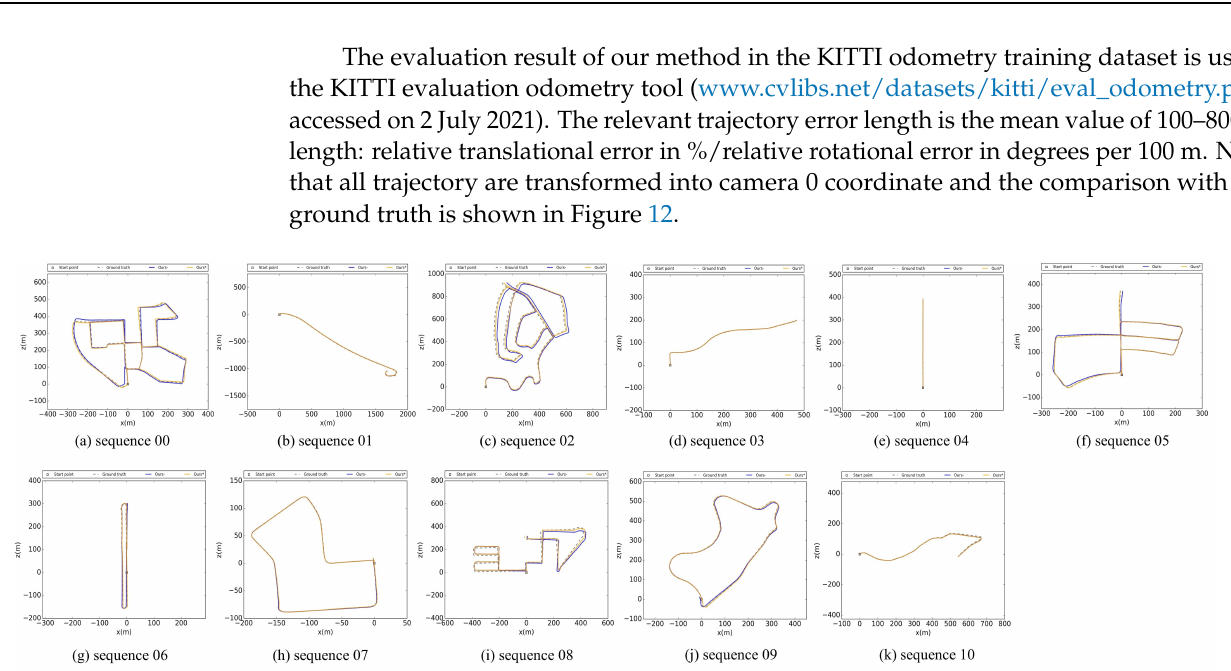
Figure 12. Trajectory diagram concerning the training set and the corresponding sequence error results are shown in Table 2. The gray dotted trajectory is ground, which is collected based on differential GPS that the localization precision is around cm level. The optimized odometry of our scheme is presented in the blue trajectory: Ours- , and the trajectory with loop closure is drawn in orange: Ours* , all of these trajectories have been aligned with the ground